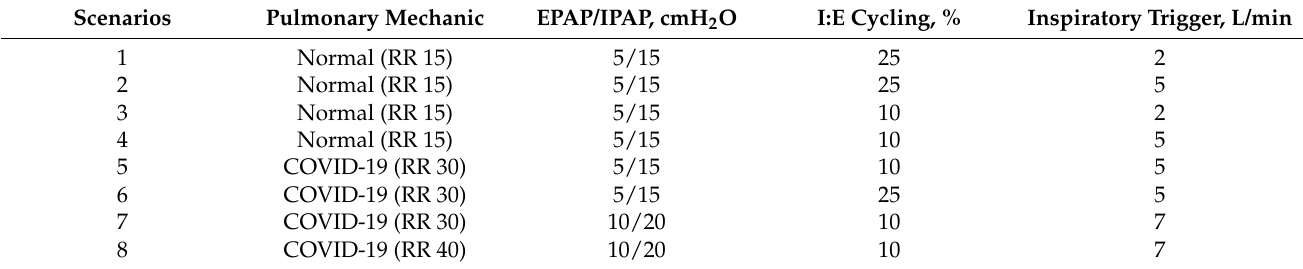
Table 1. Evaluated